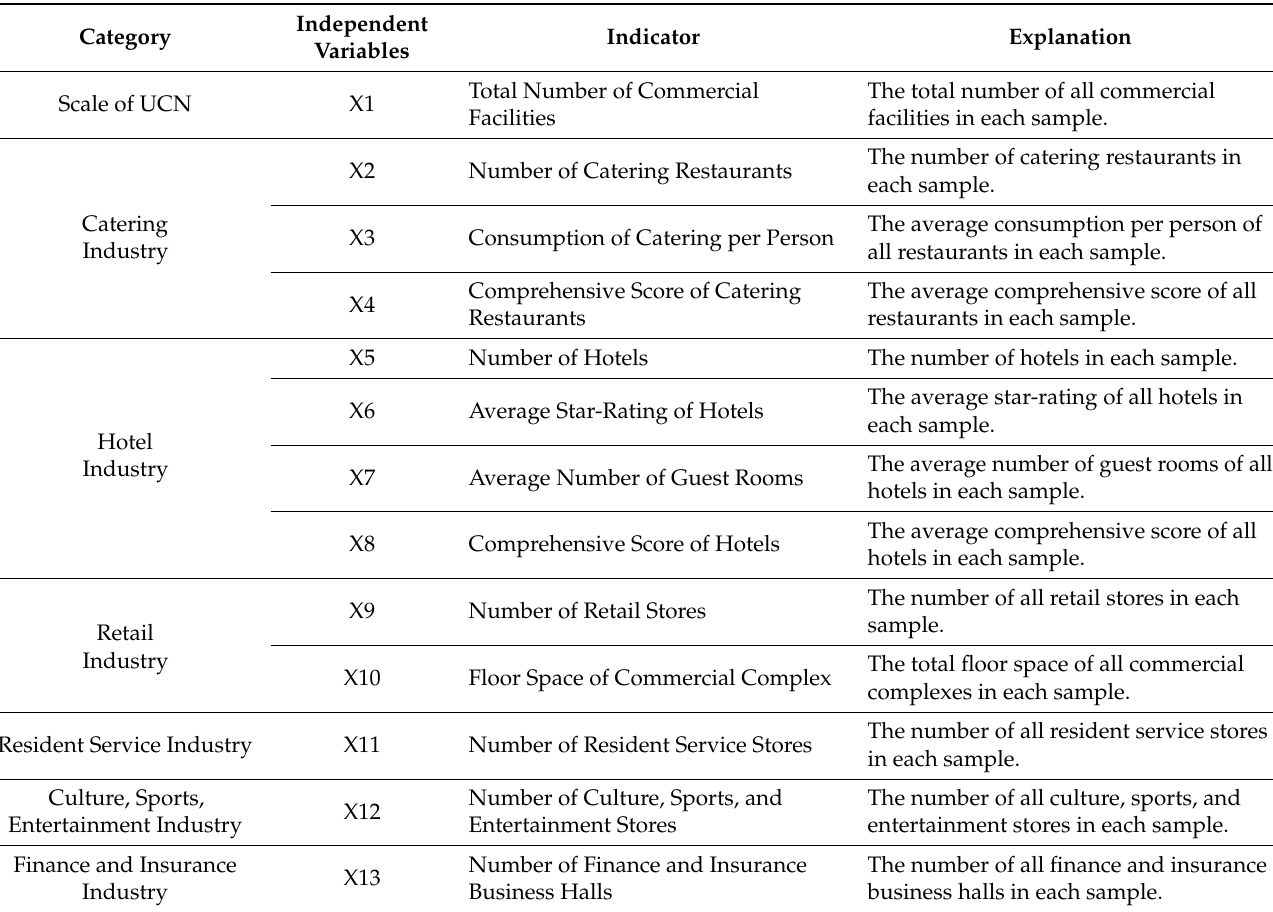
Table 4. Independent